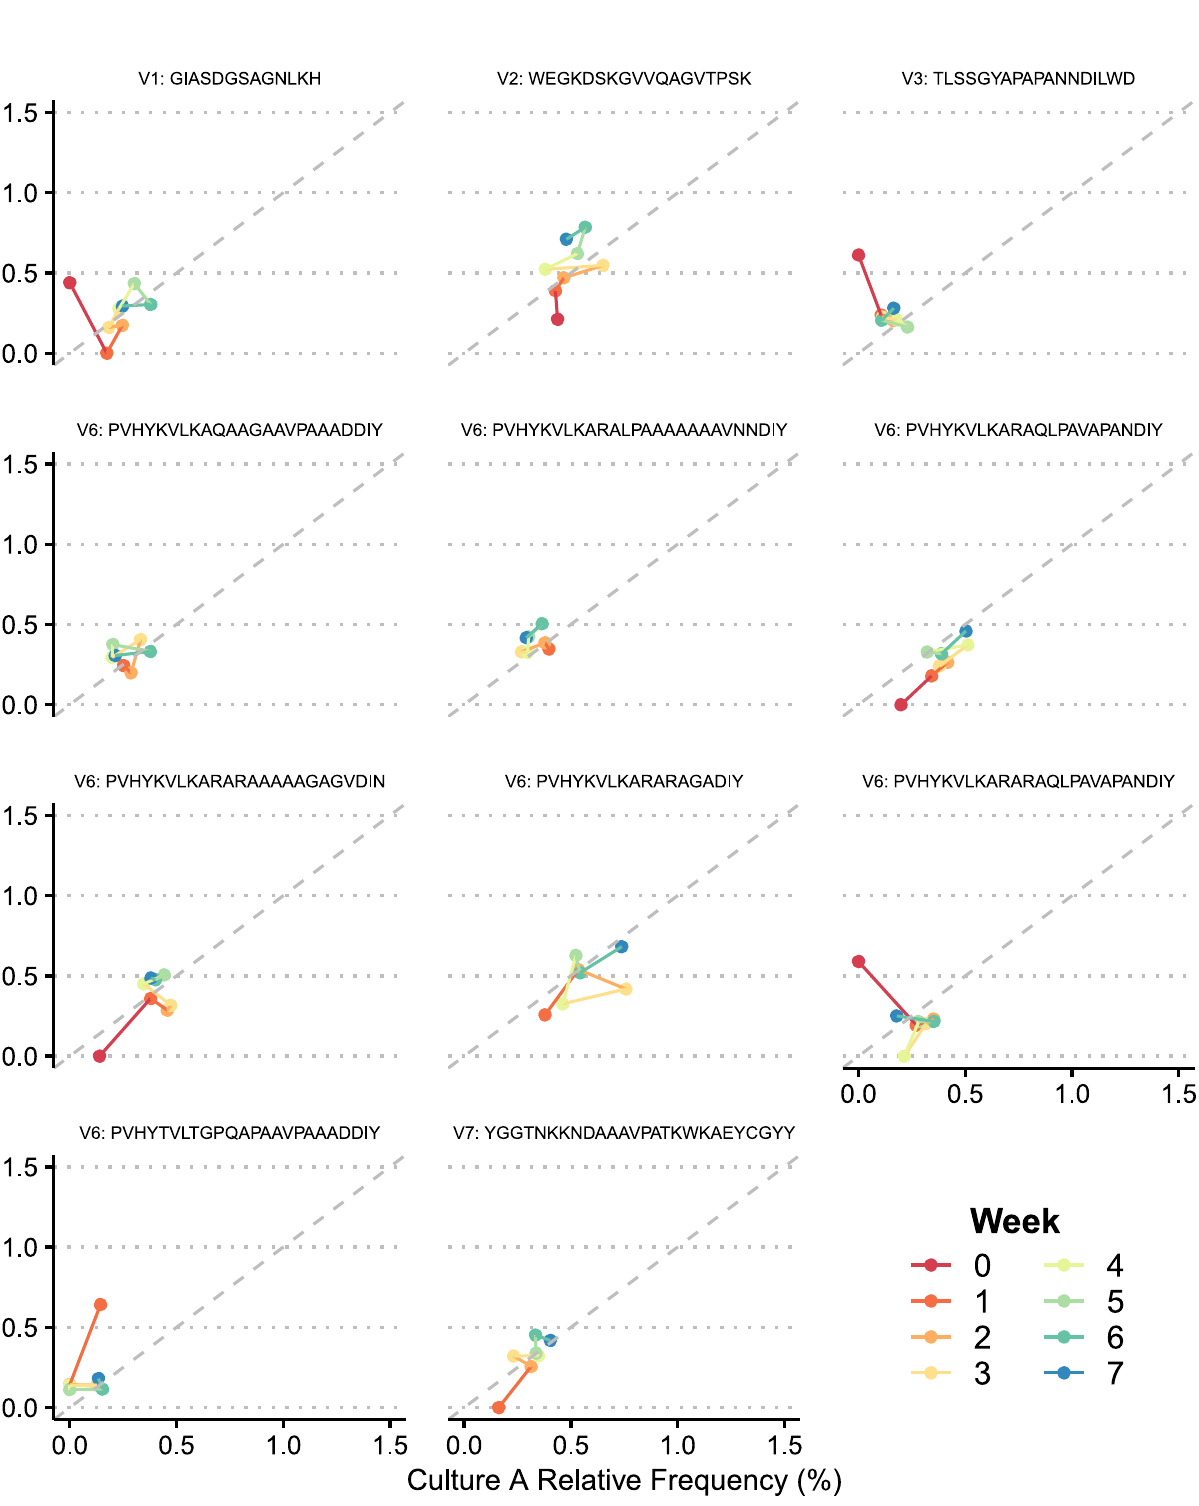
Fig 7. Comparison between culture replicates of individual novel V region alleles absent in inoculum that reached � 0.4% relative frequency at any timepoint. Unique alleles are labeled above each plot with their variable region and amino acid sequence. Lines sequentially connect each timepoint and are color-coded by